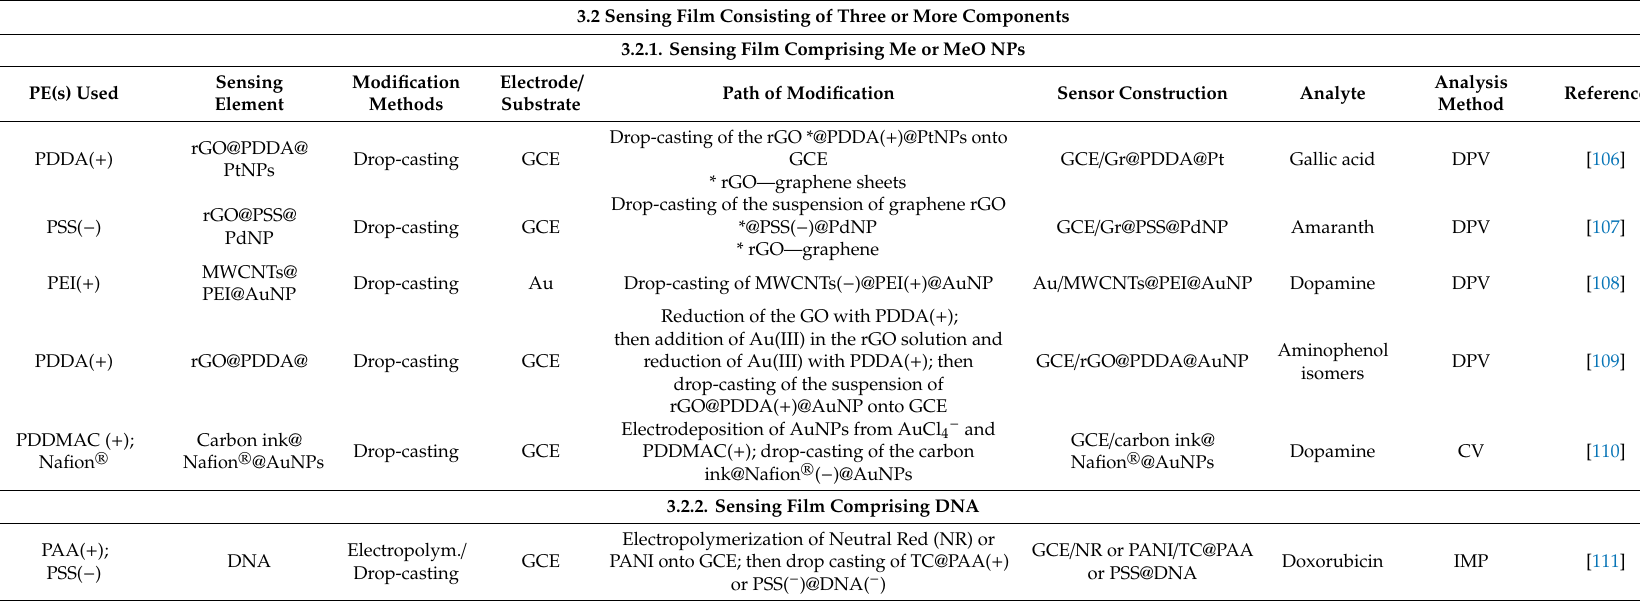
Table 6. Summary of electrochemical sensors based on a polyelectrolyte-based sensing layer composed of more than one constituent and obtained by the drop-casting or dip-coating